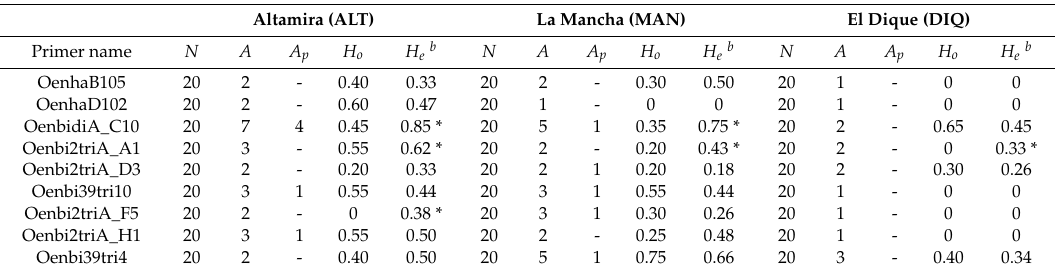
Table 3. Results of the initial primer screening in three populations of Oenothera drummondii . Altamira (ALT) La Mancha (MAN) El Dique